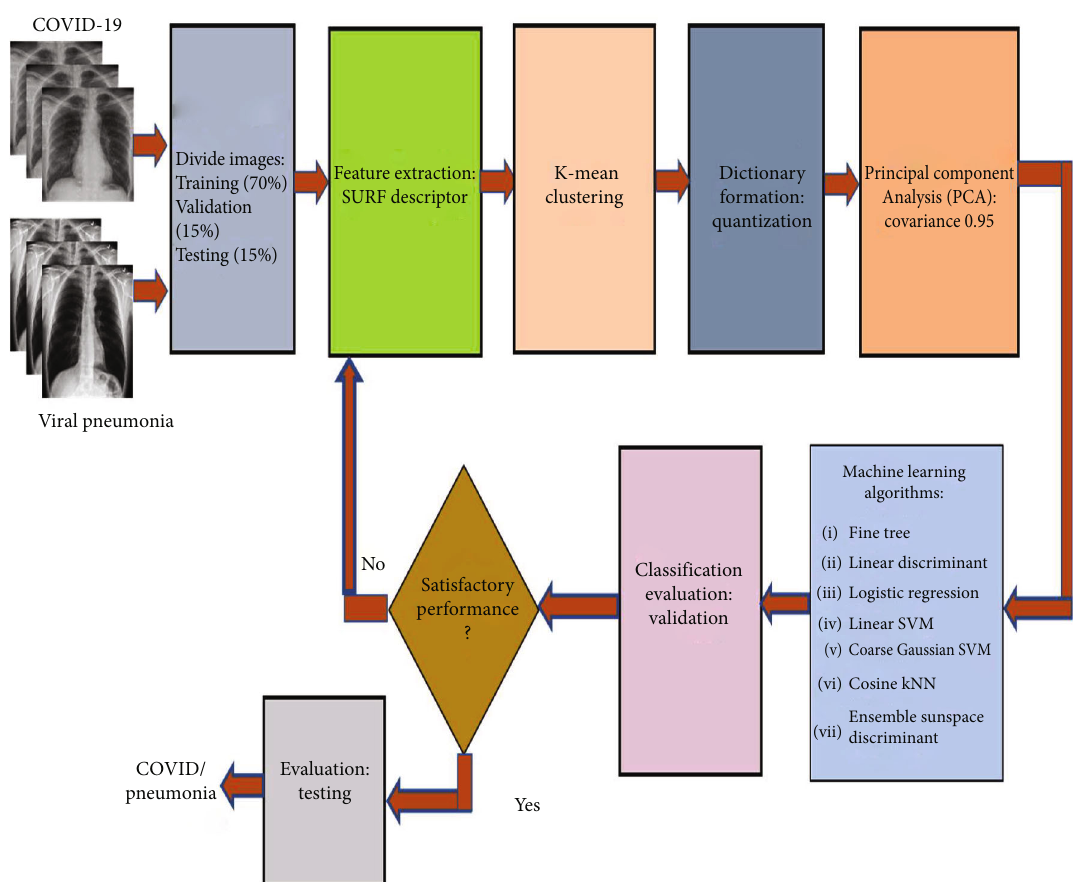
Figure 6: The system model employing the machine learning